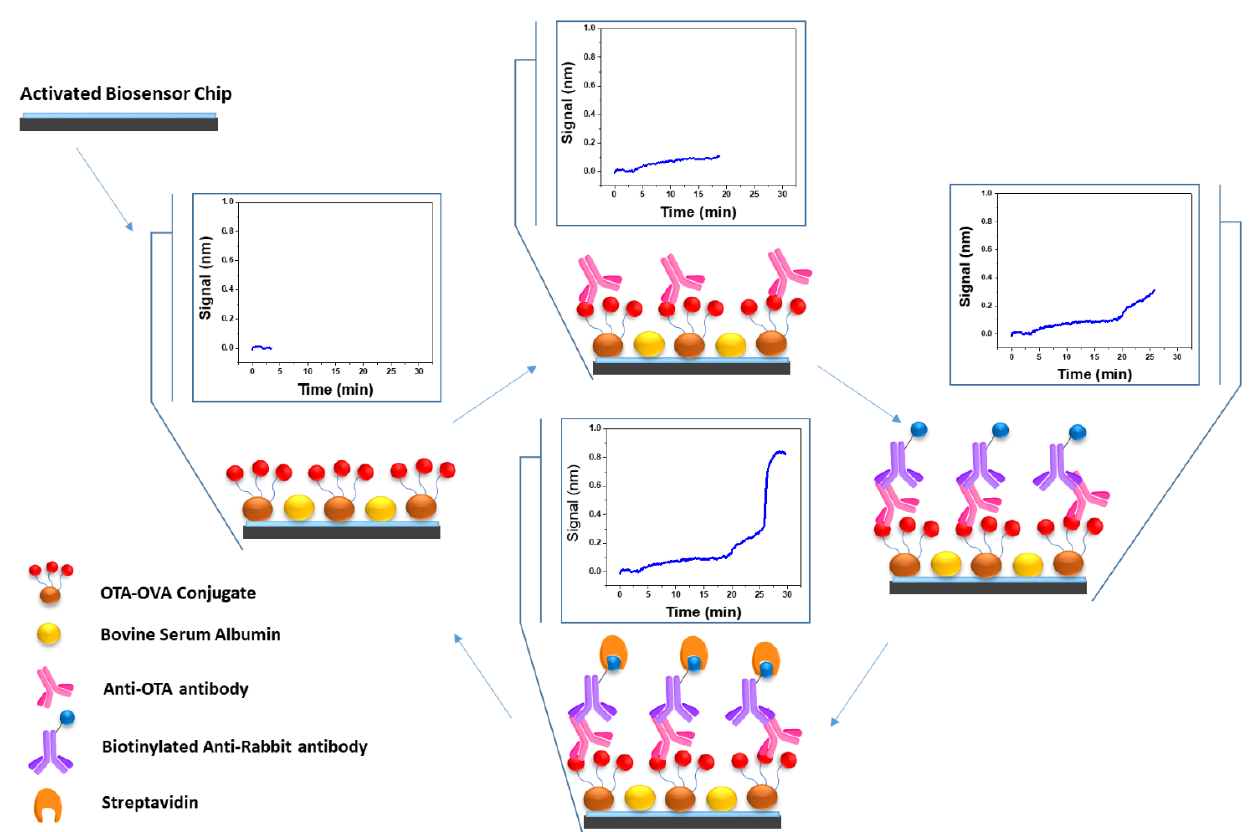
Figure 1. Scheme of assay for OTA determination with the WLRS sensor in the absence of competitor (zero calibrator). The thickness increase in the biomolecular adlayer on top of the sensor chip during the assay caused a shift of the reflectance spectrum towards higher wavelengths. By fitting with the interference equation, the thickness of the adlayer was calculated and interpreted as a signal in the real-time response